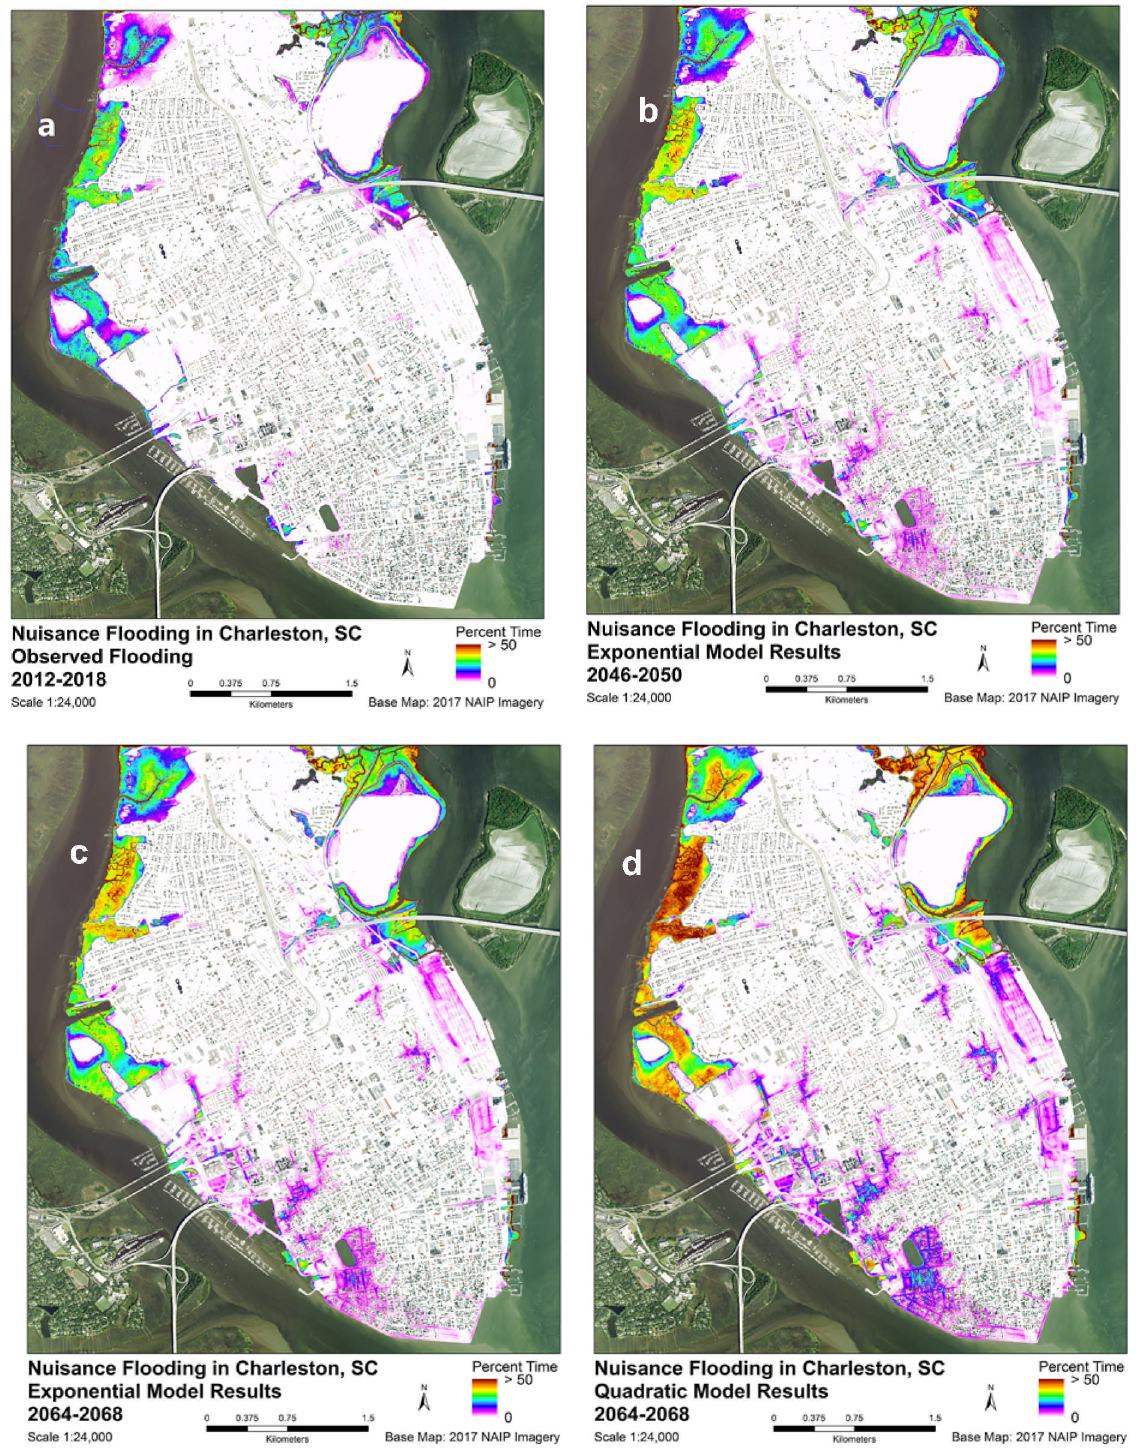
Fig 7. Spatial distribution of flood duration. Current spatial distribution of flood duration on Charleston Peninsula (a), and forecasted flood duration (proportion of time flooded) in 2046–2050 (b) from the exponential model of sea-level rise, and forecasted flood duration in 2064 to 2068 from the exponential model (c) and quadratic model (d). Basemap: 2017 NAIP Imagery acquired from USDA-FSA-APFO.